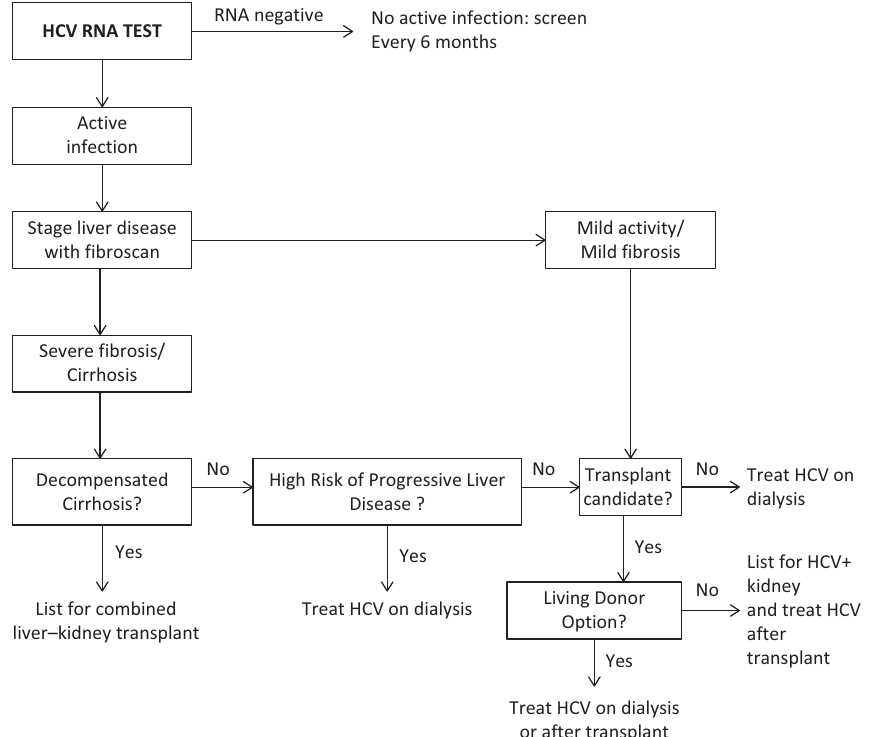
Figure 3. Algorithm for hepatitis C virus antibody positive dialysis patients to determine timing of treatment